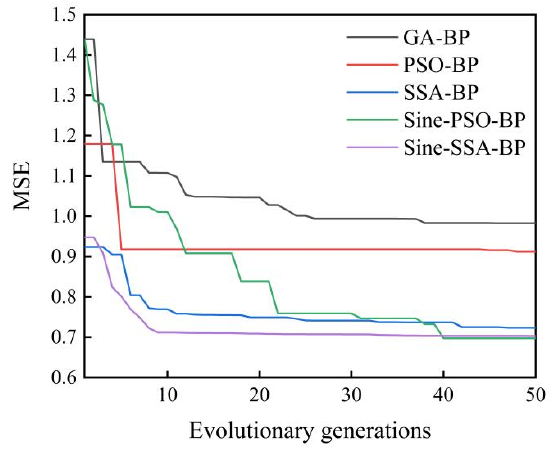
Figure 10. Comparison of evolutionary convergence curves of various algorithms.